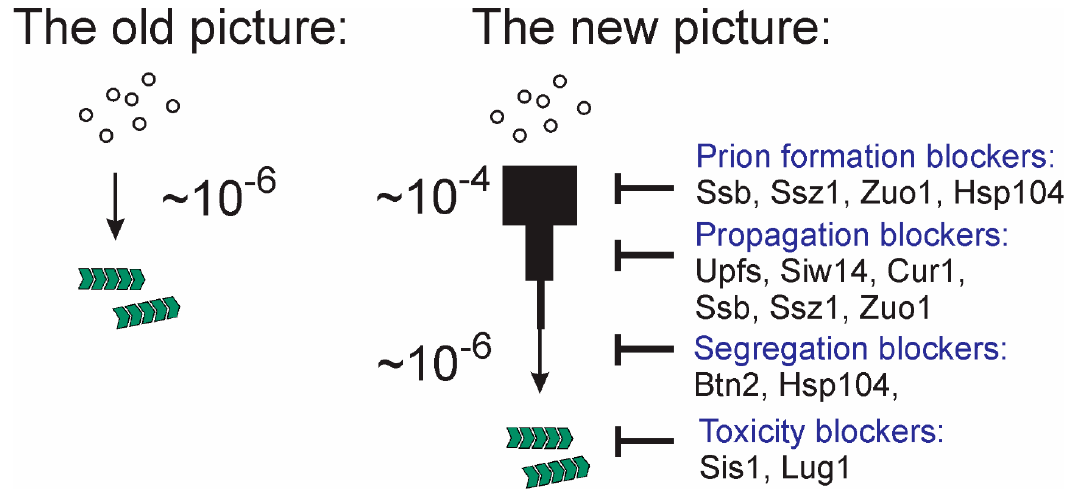
Figure 2. The existence and properties of the many yeast anti-prion systems suggest that prion formation is not a trickle, but rather a tidal wave that is attenuated by many systems at several levels. The anti-prion roles of Siw14 and Cur1 are not yet clear, but are listed here as blocking prion “propagation” in the broad sense.